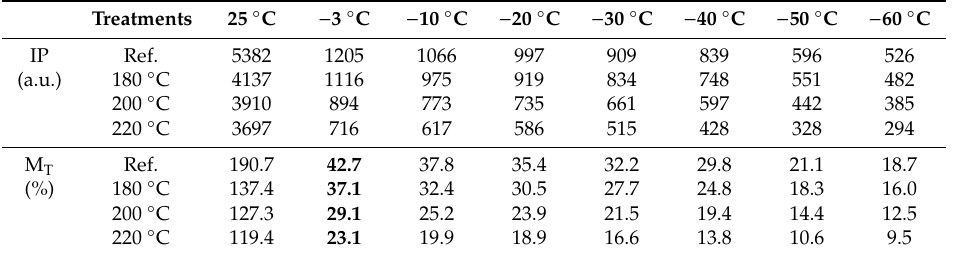
Table 5. The integral of the peaks (IP) and content of unfrozen water (M T ) of Norway spruce at di ff erent temperatures.